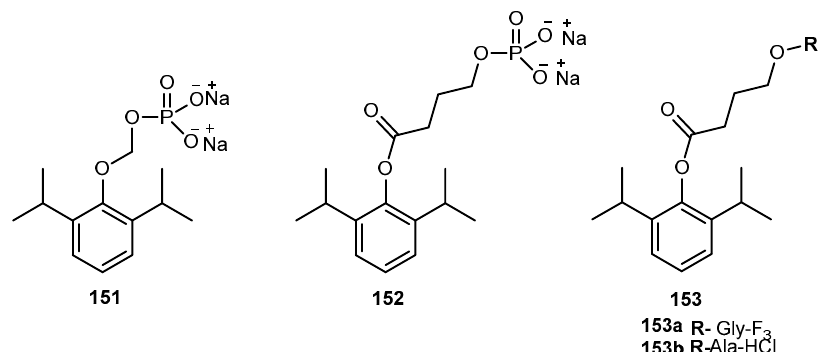
Figure 65. Chemical structures of phosphate and amino acids prodrugs of 149.